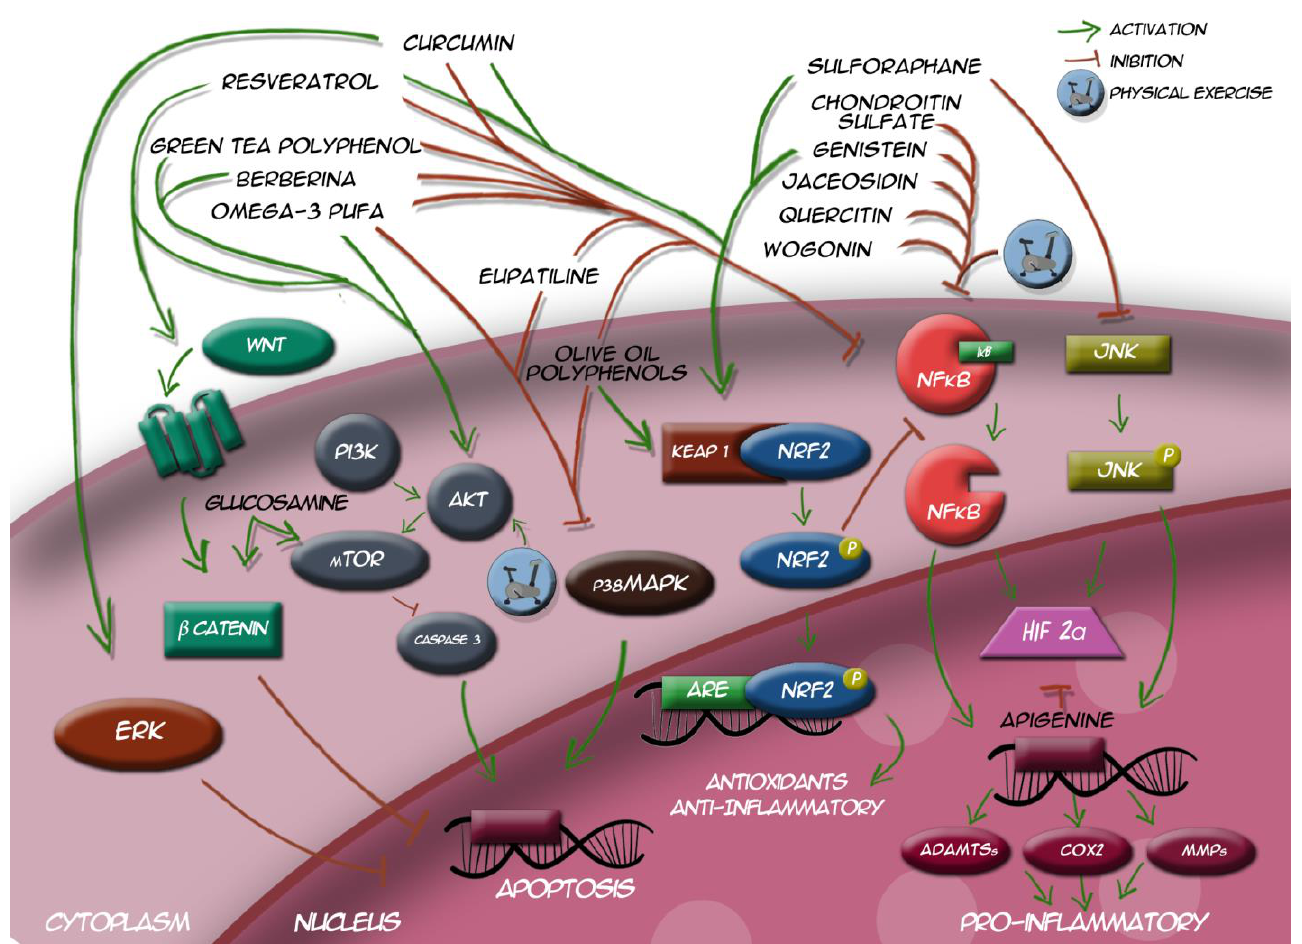
Figure 1. Involvement of nutraceuticals and exercise in molecular pathways for apoptotic, pro-, or anti-inflammatory sig- naling.